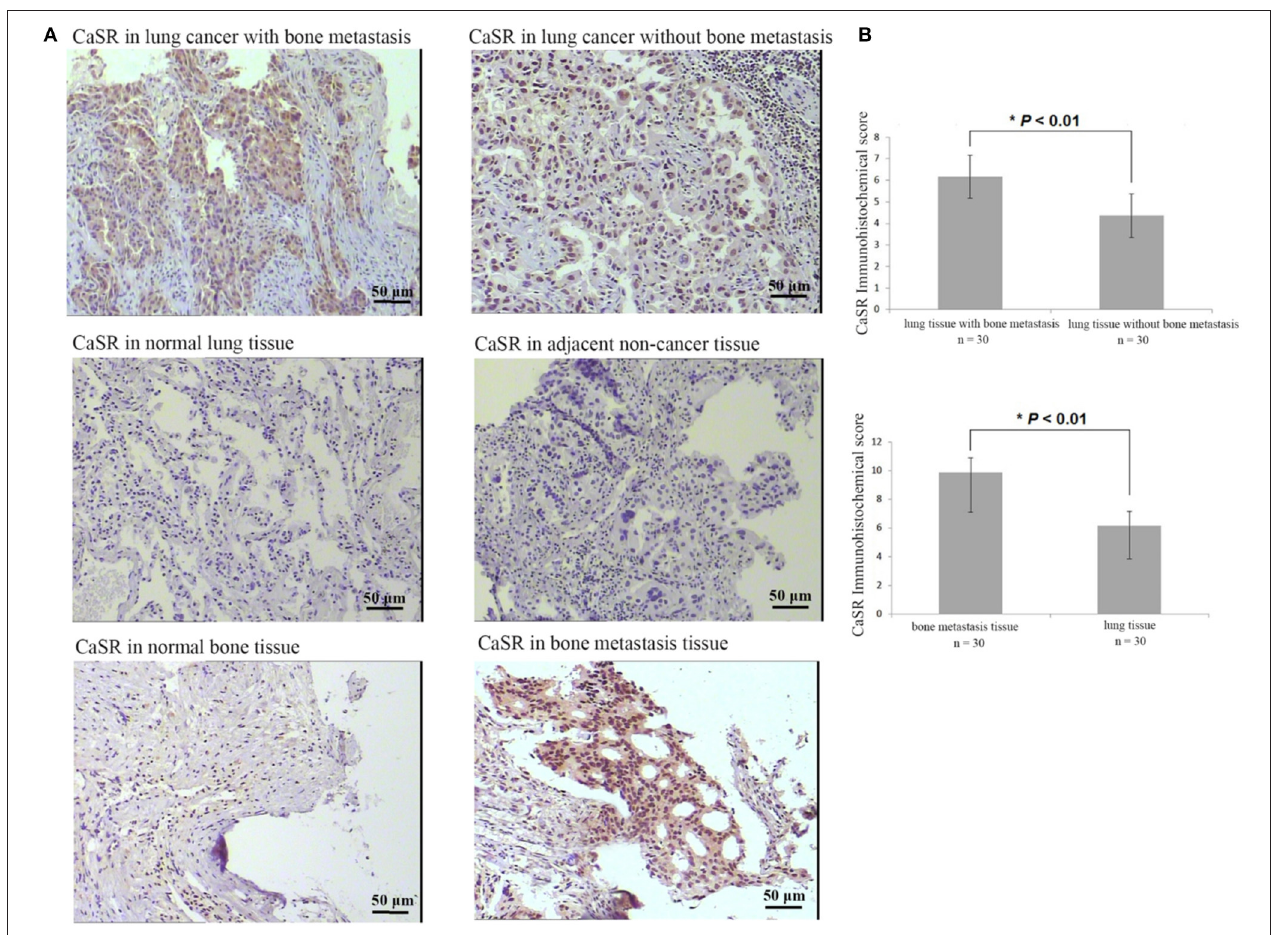
FIGURE 1 | Analysis of CaSR expression in lung cancer tissues, lung cancer bone metastasis tissues, and bone tissue metastasis samples. (A) Typical immunohistochemistry (IHC) staining results. (B) In lung cancer tissues, CaSR expression was significantly higher in bone metastasis group than in non-bone metastasis group ( p < 0.01). In bone tissues, CaSR expression was significantly higher in bone metastasis group than in normal group ( p < 0.01). * p <